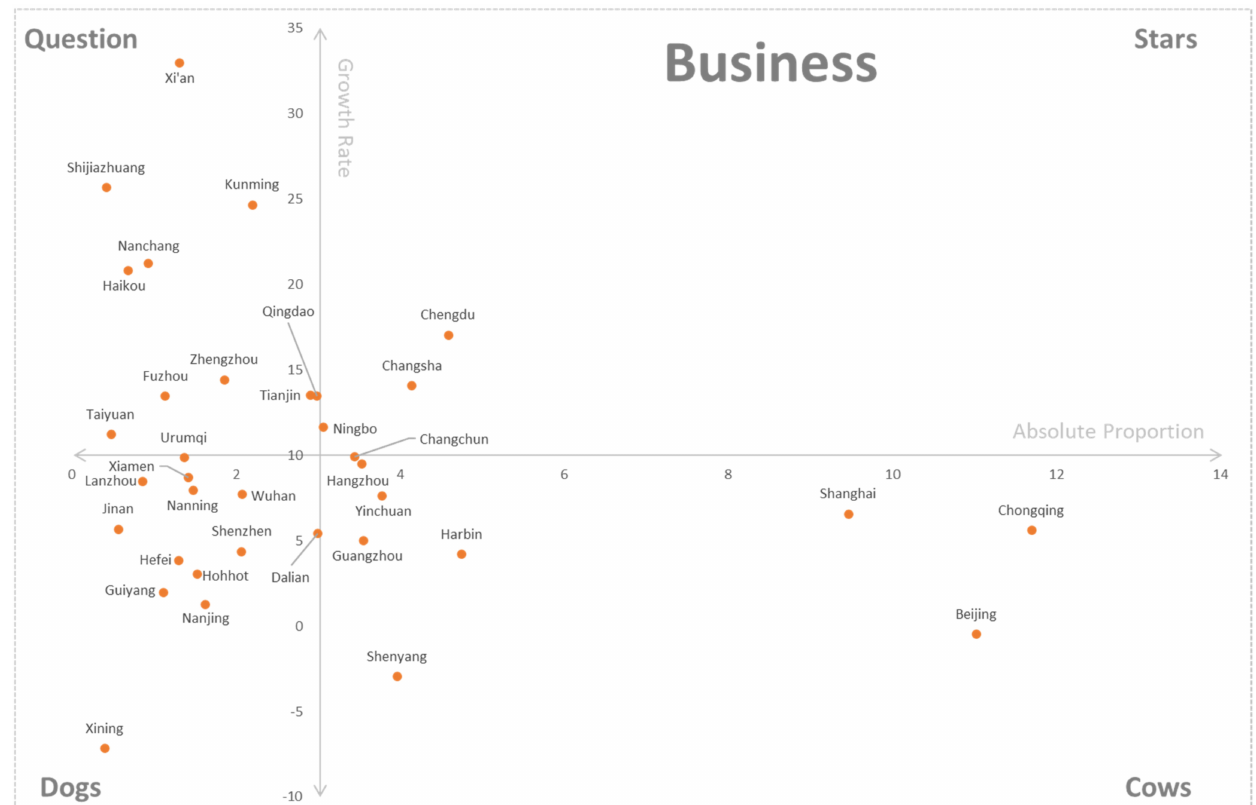
Figure 12. Policy zoning of urban real estate inventory